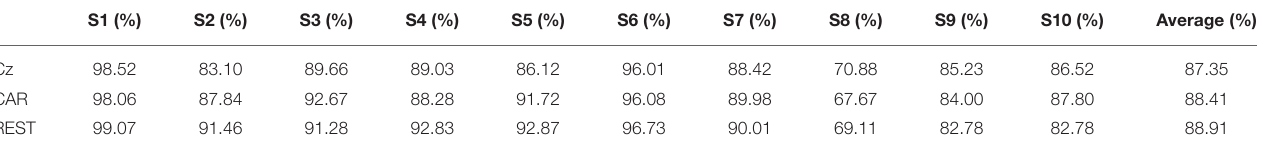
TABLE 1 | Accuracy of classification accuracy between idle and RP periods in three references over all 10